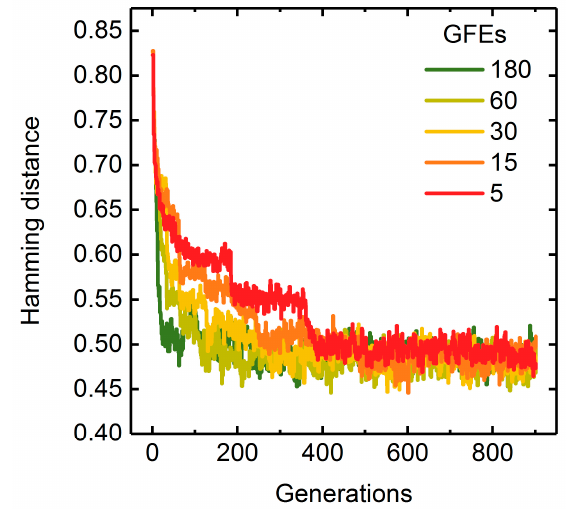
Figure 7. Hamming distance progressions for GA runs applying 5 to 180 GFEs while keeping the total generation number at 900. Deletion of maximally seven reactions were allowed. Succinate BPCY was used as the engineering objective. Error bars denote the standard deviation of five replicate GA runs.